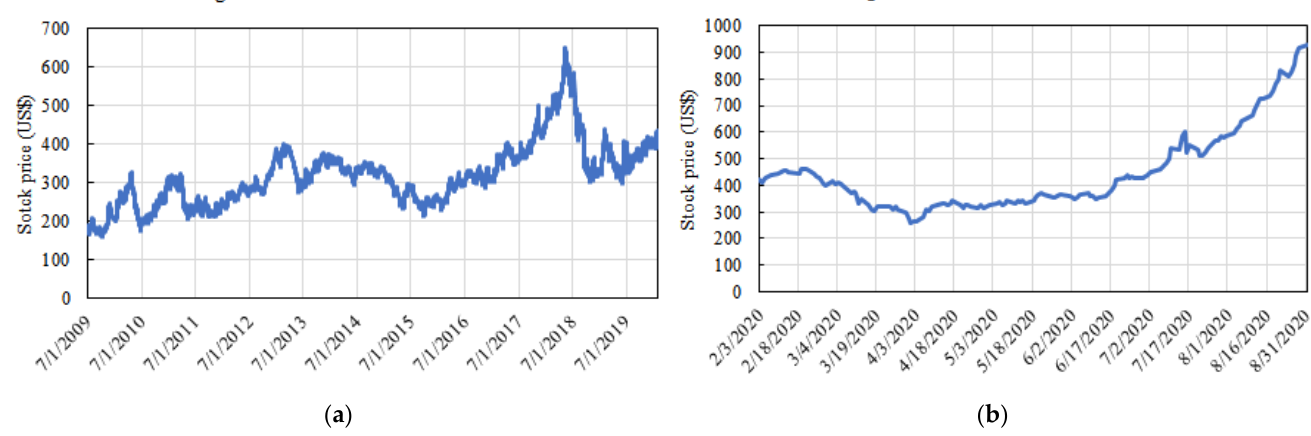
Figure 2. Evolution of training set ( a ) and testing set ( b ) over time for the Random Length stock price for the COVID-19 recession modeling.